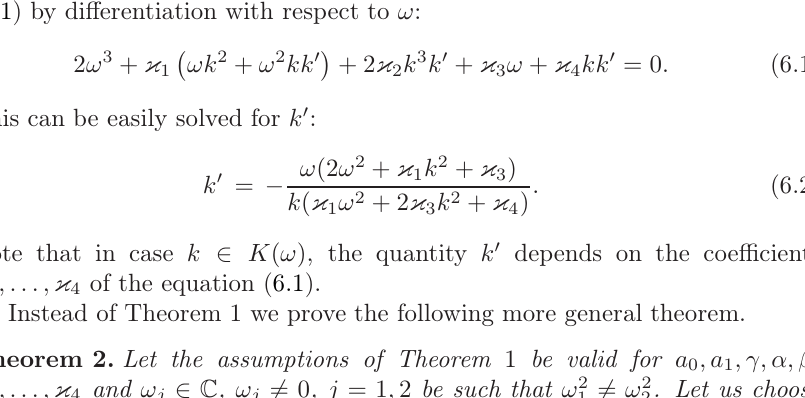
Table 2. Relative errors in case a